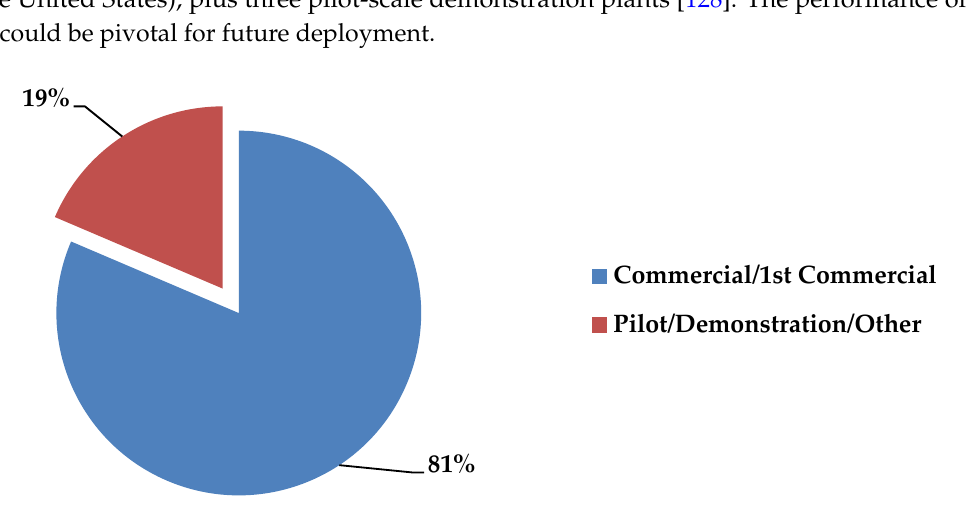
Figure 6. Advanced biofuel capacity per year—operational, 225.43 million gallons/year. Data adapted from [127].